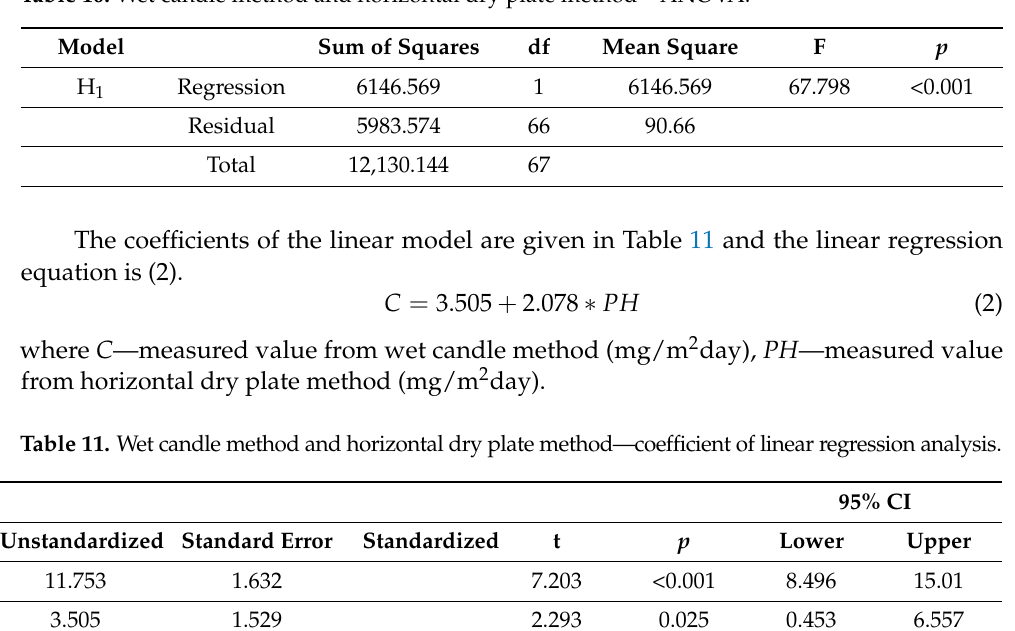
Table 10. Wet candle method and horizontal dry plate method—ANOVA.